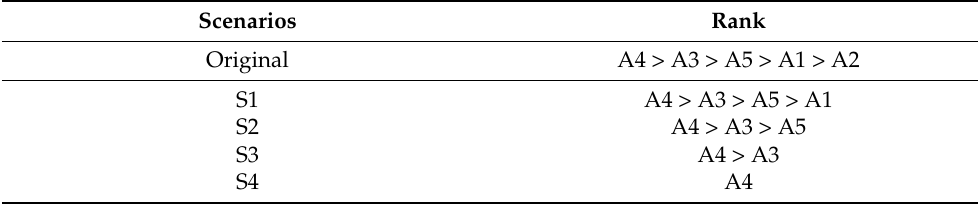
Table 13. The results for testing the model to the rank reversal